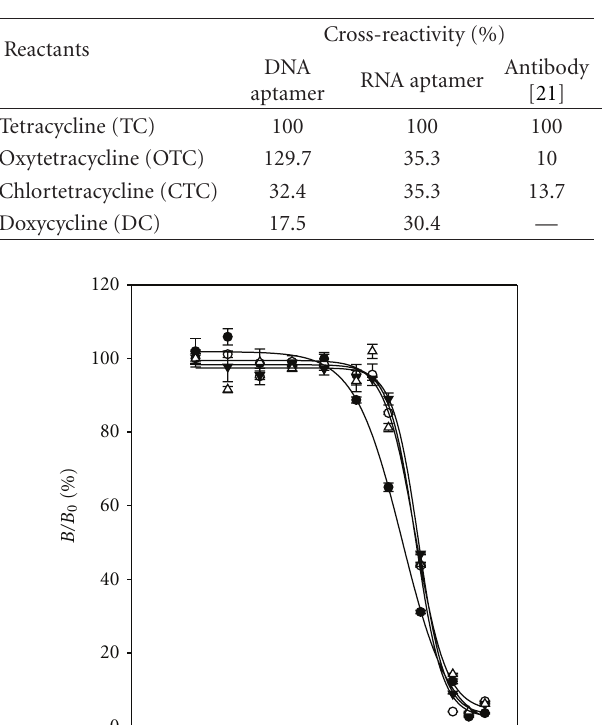
Table 1: Cross-reactivity (%) of cross-reactants.